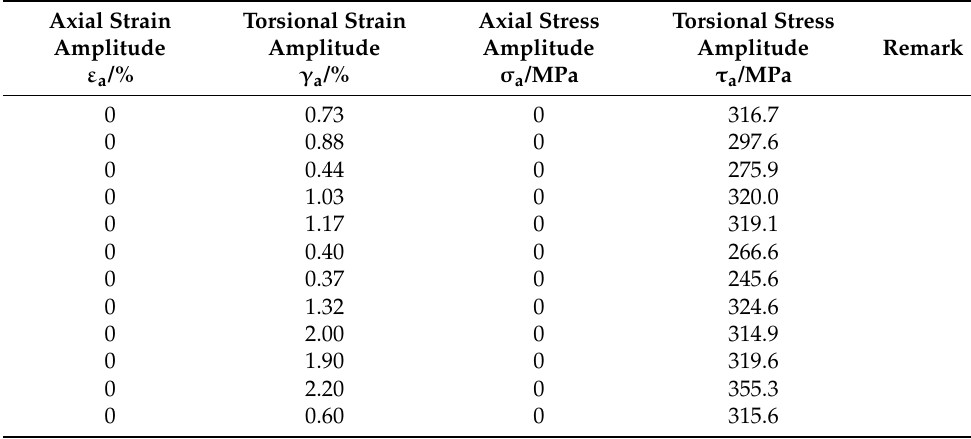
Table A7. Test results for pure torsional tests.